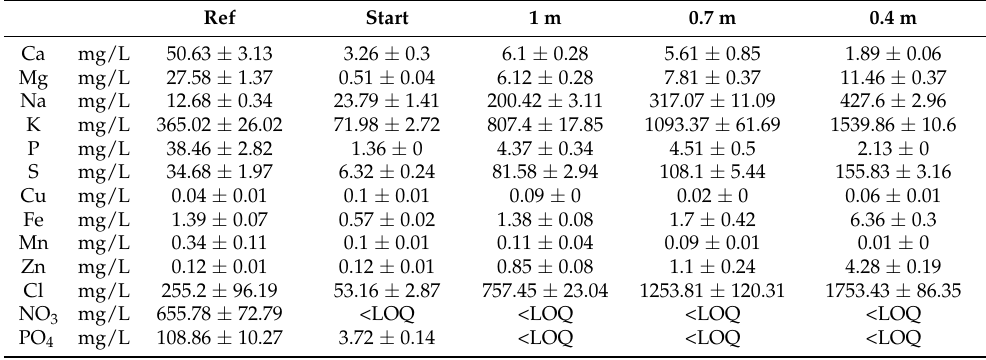
Table A7. The measured nutrient uptake by the duckweed in the simulated system, during cultiva- tion ± standard deviations. ‘Start’ = the composition of the growing medium of a continuous system at the start of the growing season; ‘1 m’/‘0.7 m‘/’0.4 m’ the composition of the growing medium of a